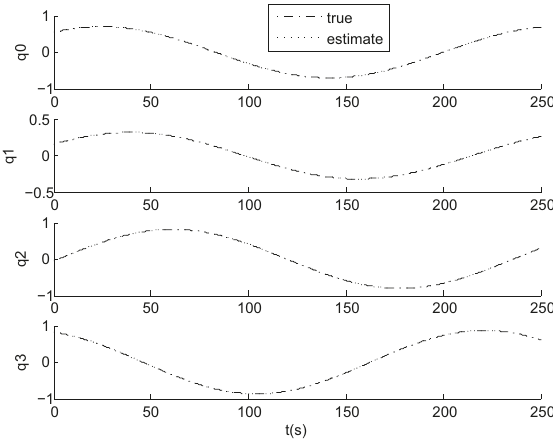
Figure 6. Attitude estimation results in simulation.